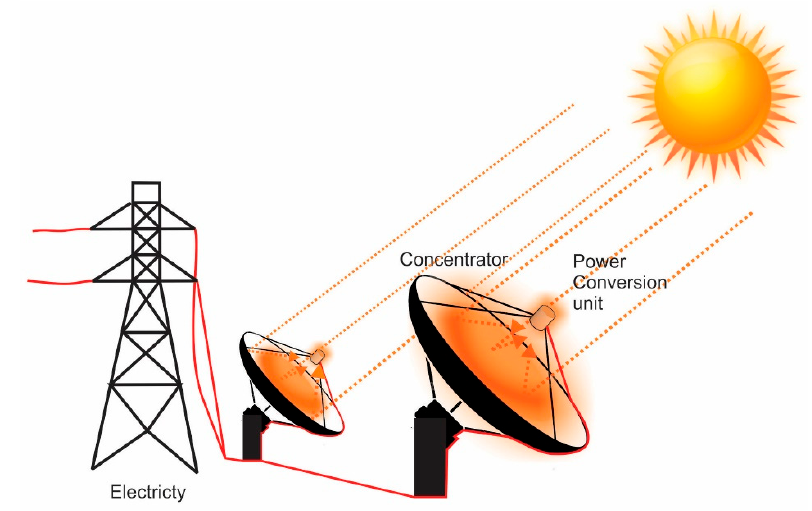
Figure 9. Solar thermal electricity generation of a parabolic dish.